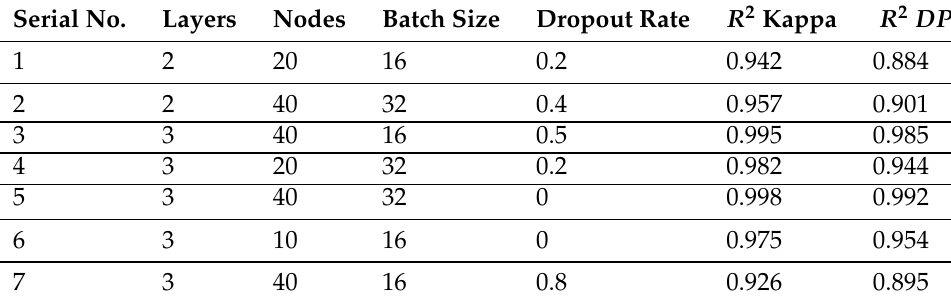
Table 3. List of configurations for the LSTM network. Serial